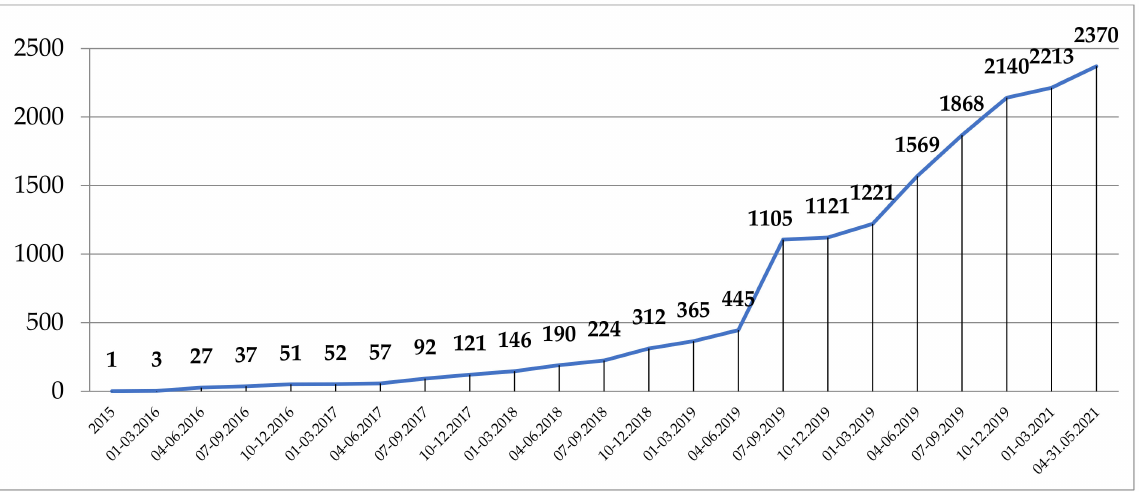
Figure 1. Dynamics of issuing IRCC from 2015 till 31 May